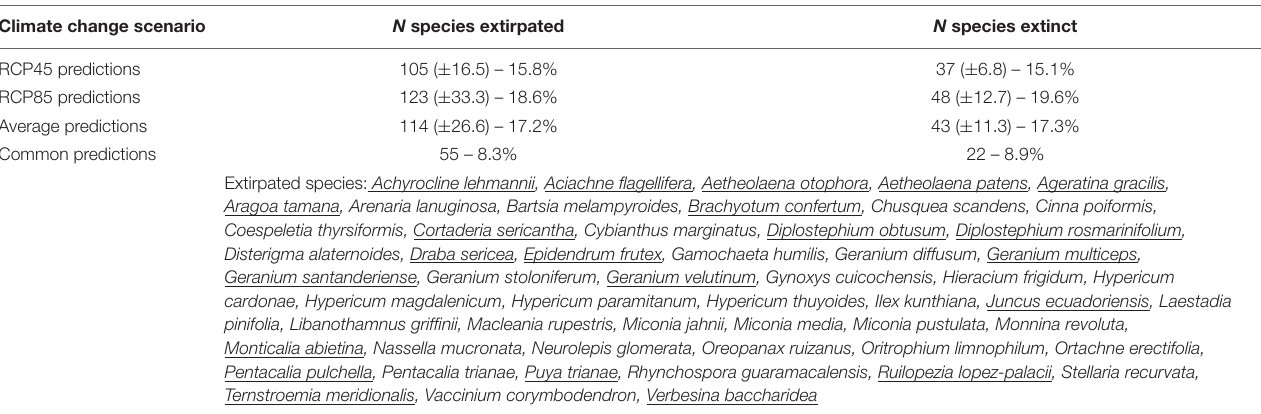
TABLE 1 | Predictions of the extirpation and extinction risks for páramo plants by 2070 according to climate change scenarios considering two Representative Concentration Pathways, RCP45 and RCP85, and for each, five averaged General Circulation Models (CNRM, FGOALS, IPSL, MPI, and MRI). Climate change